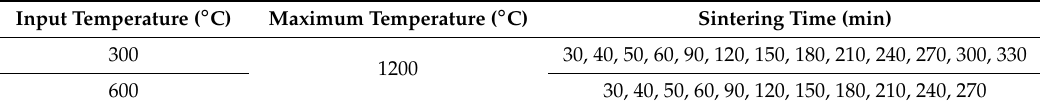
Table 2. Sintering conditions for artificial lightweight